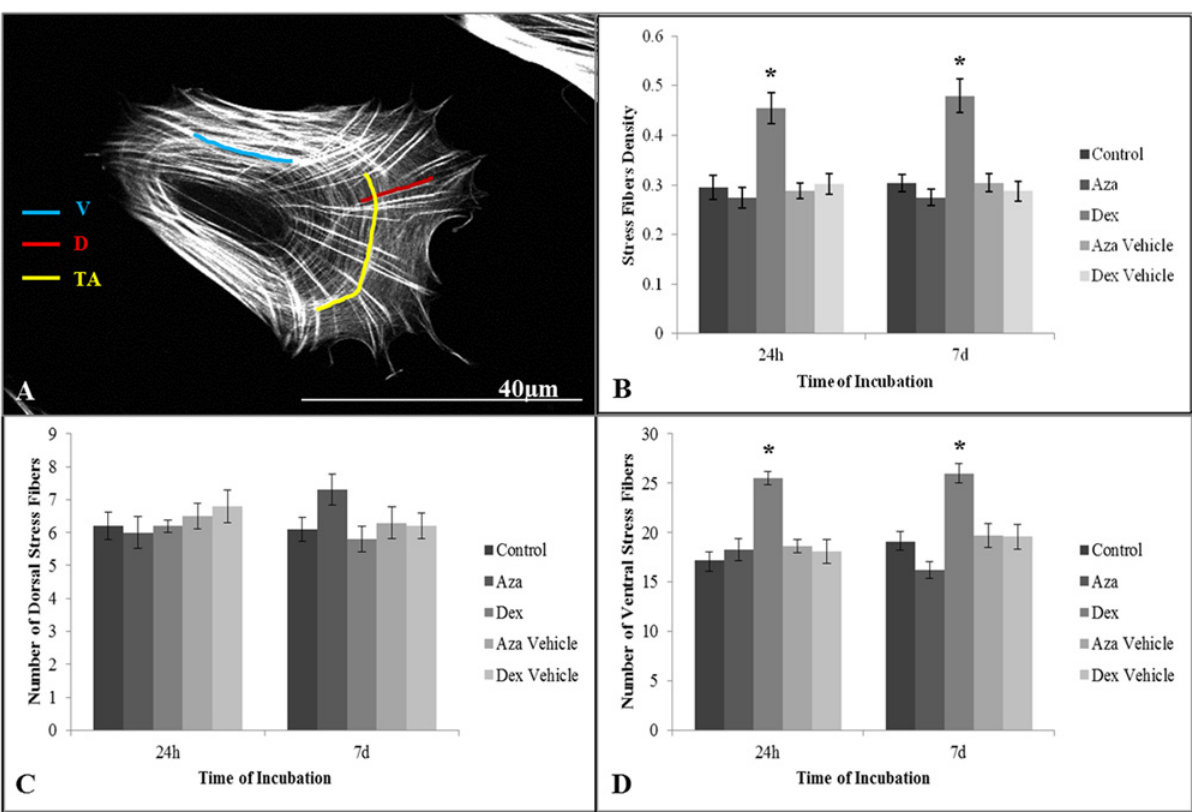
Fig 6. Actin analysis. MSCs were cultured for 24 h or 7 d with or without drugs and stained with rhodamine-phalloidin in order quantify actin density and dorsal or ventral stress fibers (A) through Image J. MSCs treated with DEX presented an increase in actin density (B) , consistent with a higher presence of ventral actin stress fibers (D) . None of the drugs seemed to alter significantly the presence of dorsal stress fibers (C) , while AZA did not show any difference in actin density (B) and ventral stress fibers (D) . * P < 0.05, n = 20. D = Dorsal stress fibers; V = Ventral stress fibers; TA = Transversal arcs of stress fibers. Actin quantification was analyzed through ANOVA post-hoc SNK. Bar = 40 μ